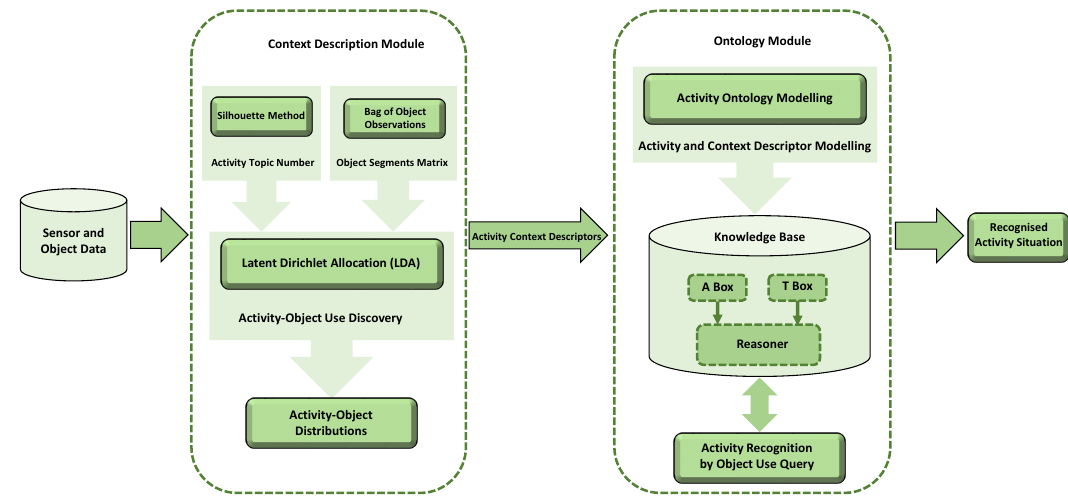
Figure 1. An Overview of the Activity Recognition